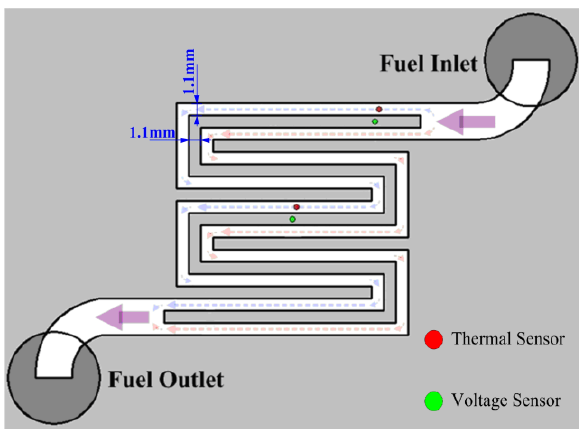
Figure 8. Locations of micro sensors.